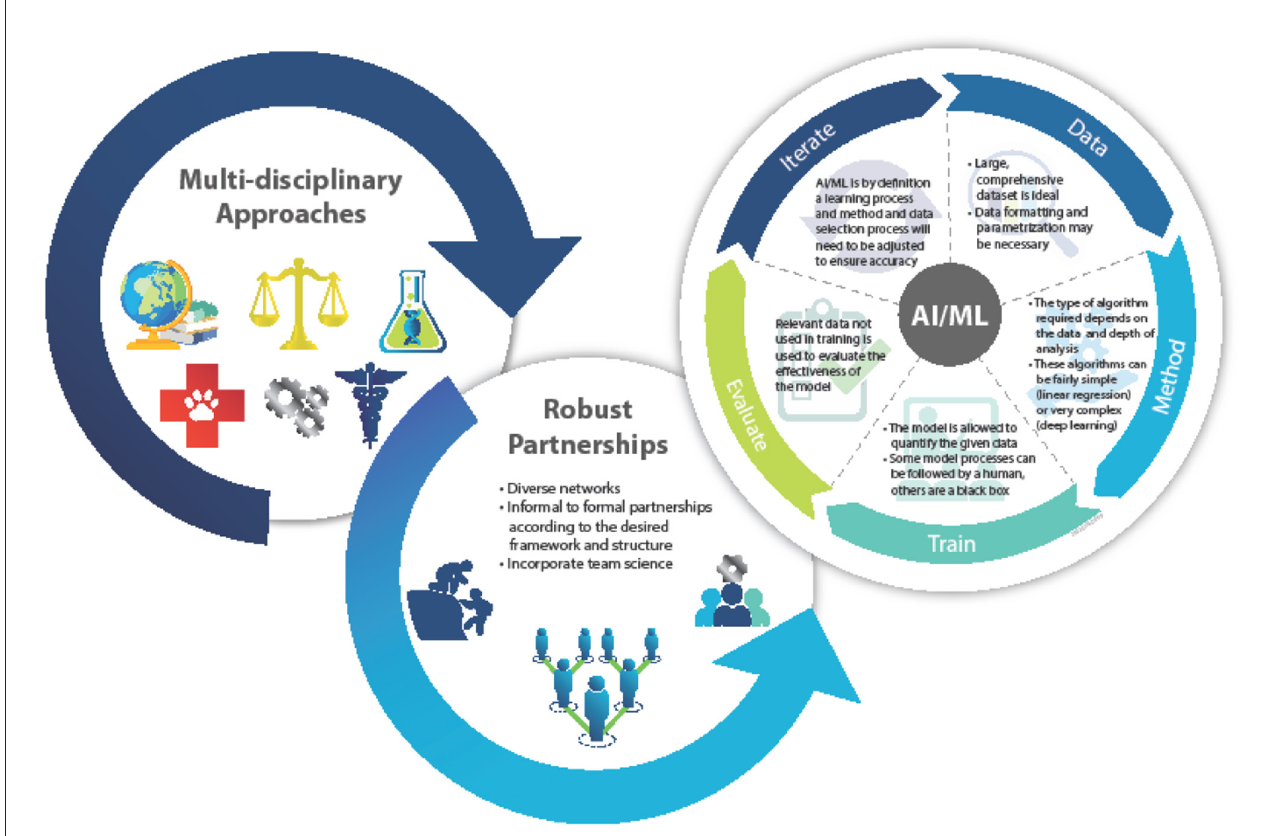
FIGURE1 Depiction of the AI/ML modeling process. Defining the analysis and function ensures an accurate and precise